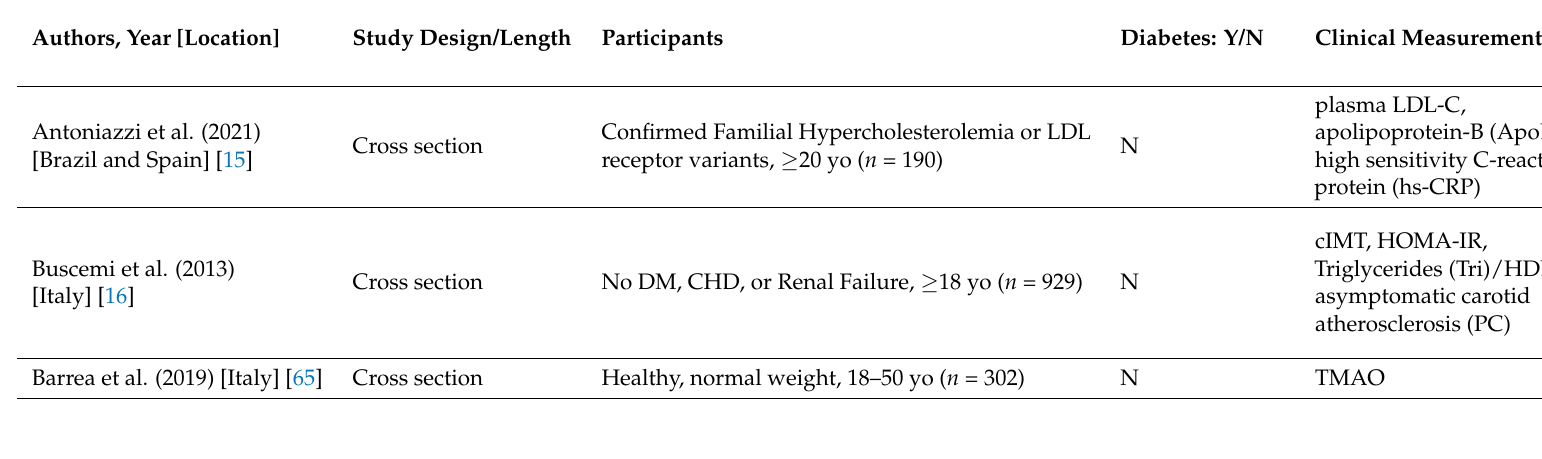
Table 2. Clinical